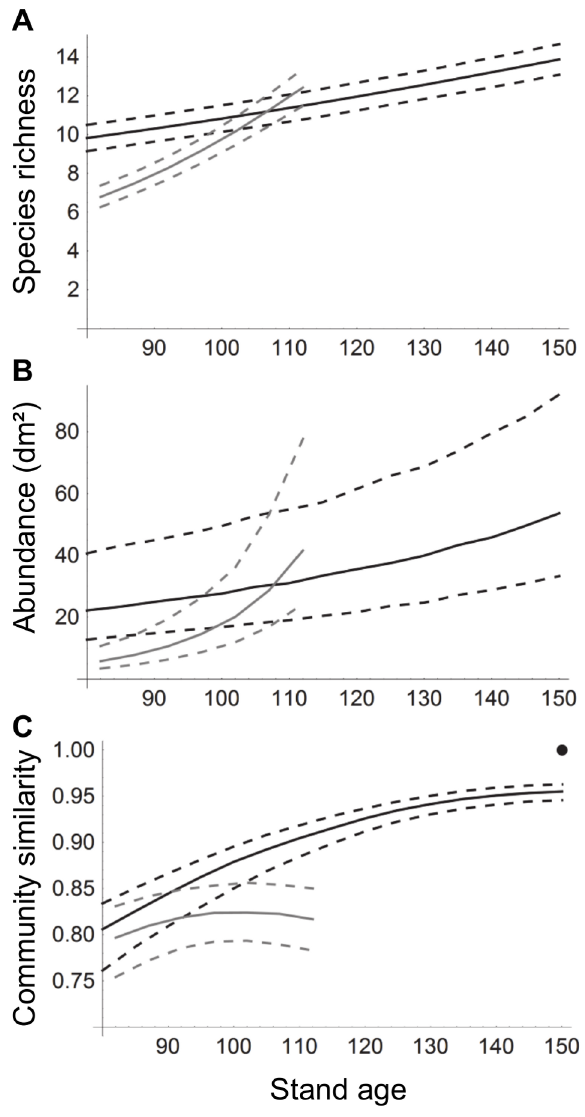
Figure 4. Relationship between stand age and bryophyte species richness (a), abundance (b) and community structure (c). The black lines correspond to aspens in uncut conservation sites, the grey lines correspond to retention aspens in forests that are cut at the stand age of 80 years. Continuous lines show median estimates, dashed lines the interquartile range. Community similarity (c) is measured against a modelled reference community (marked with of an aspen that has 60 cm diameter and that occurs in an uncut forest with stand age 150 years. Community structure is based on the presence-absence model.